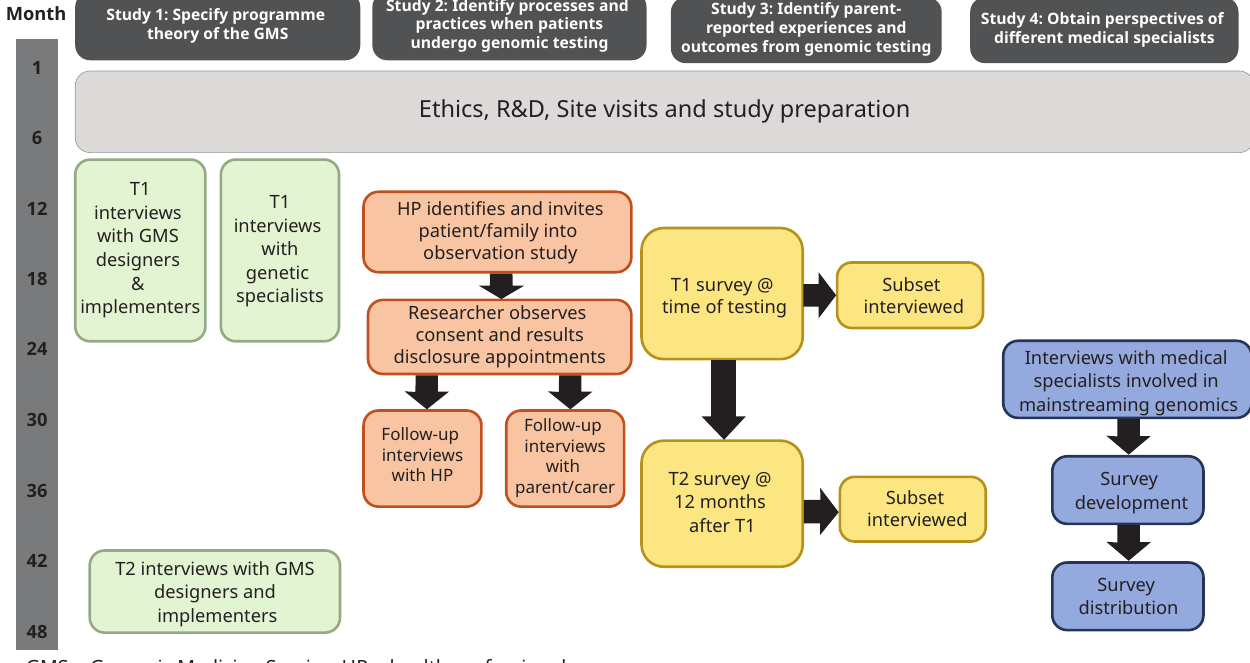
Figure 1. Overview of study